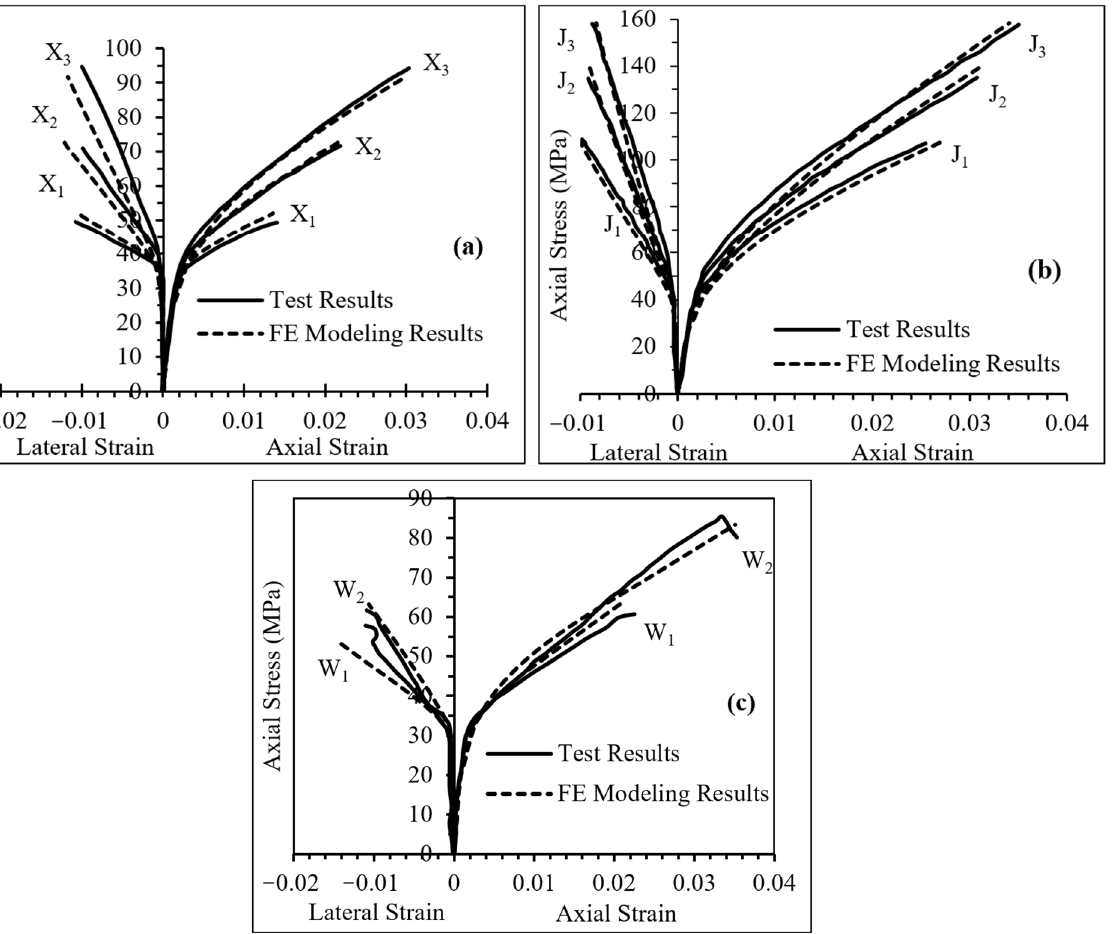
Figure 2. Comparison of FE modeling and experimental test results: ( a ) Specimens X1, X2 and X3, ( b ) Specimens J1, J2 and J3 and ( c ) Specimens W1 and W2.